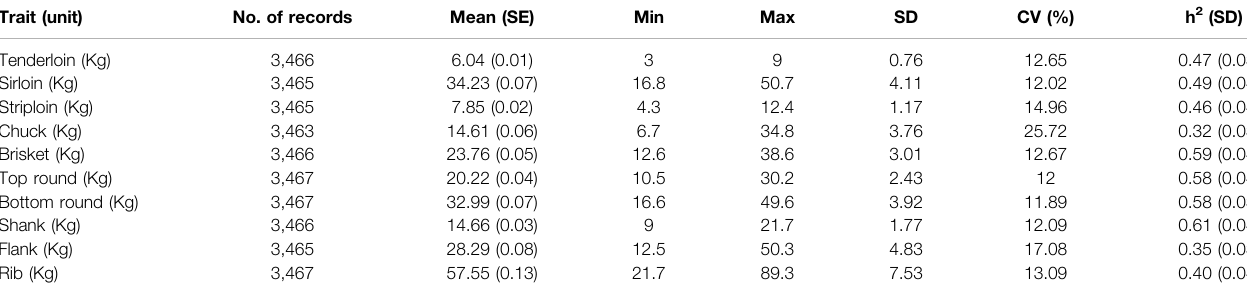
TABLE 1 | Descriptive statistics and heritability estimates for the primal cut traits in Hanwoo cattle. Trait